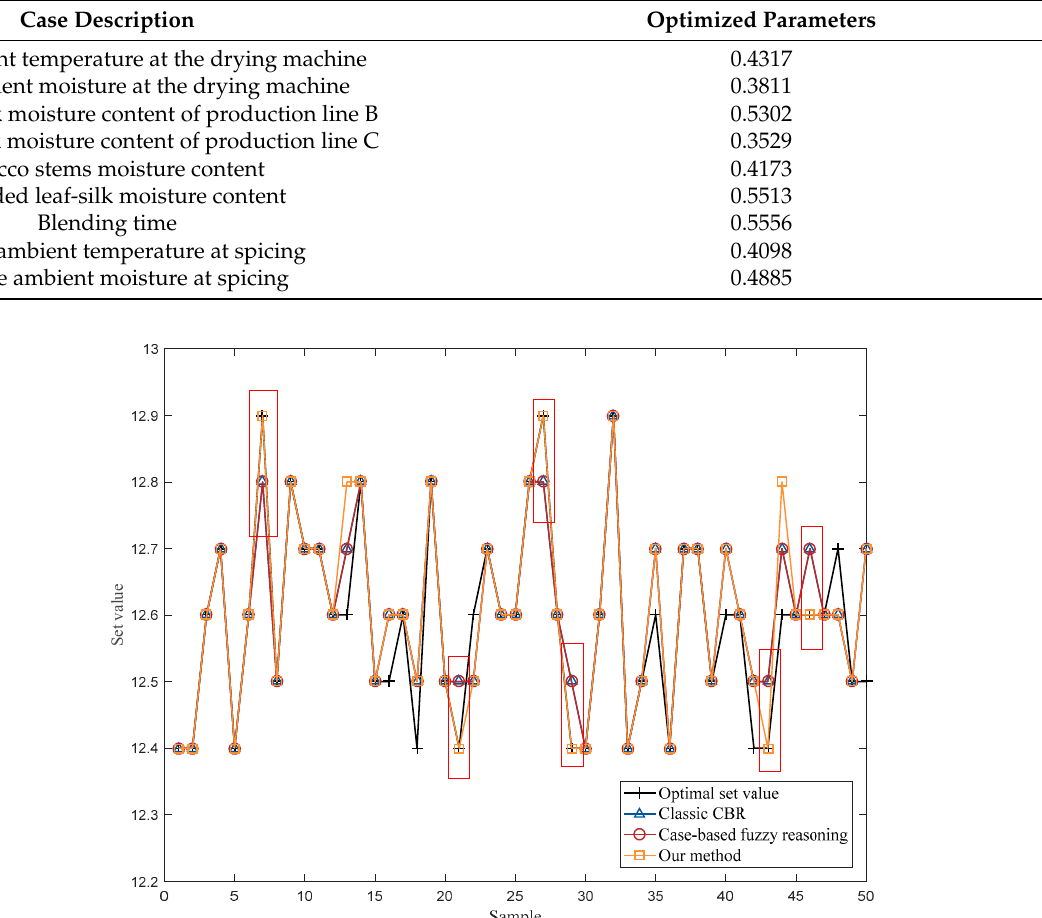
Table 4. Optimized parameters of Gaussian membership function in the industrial case study.